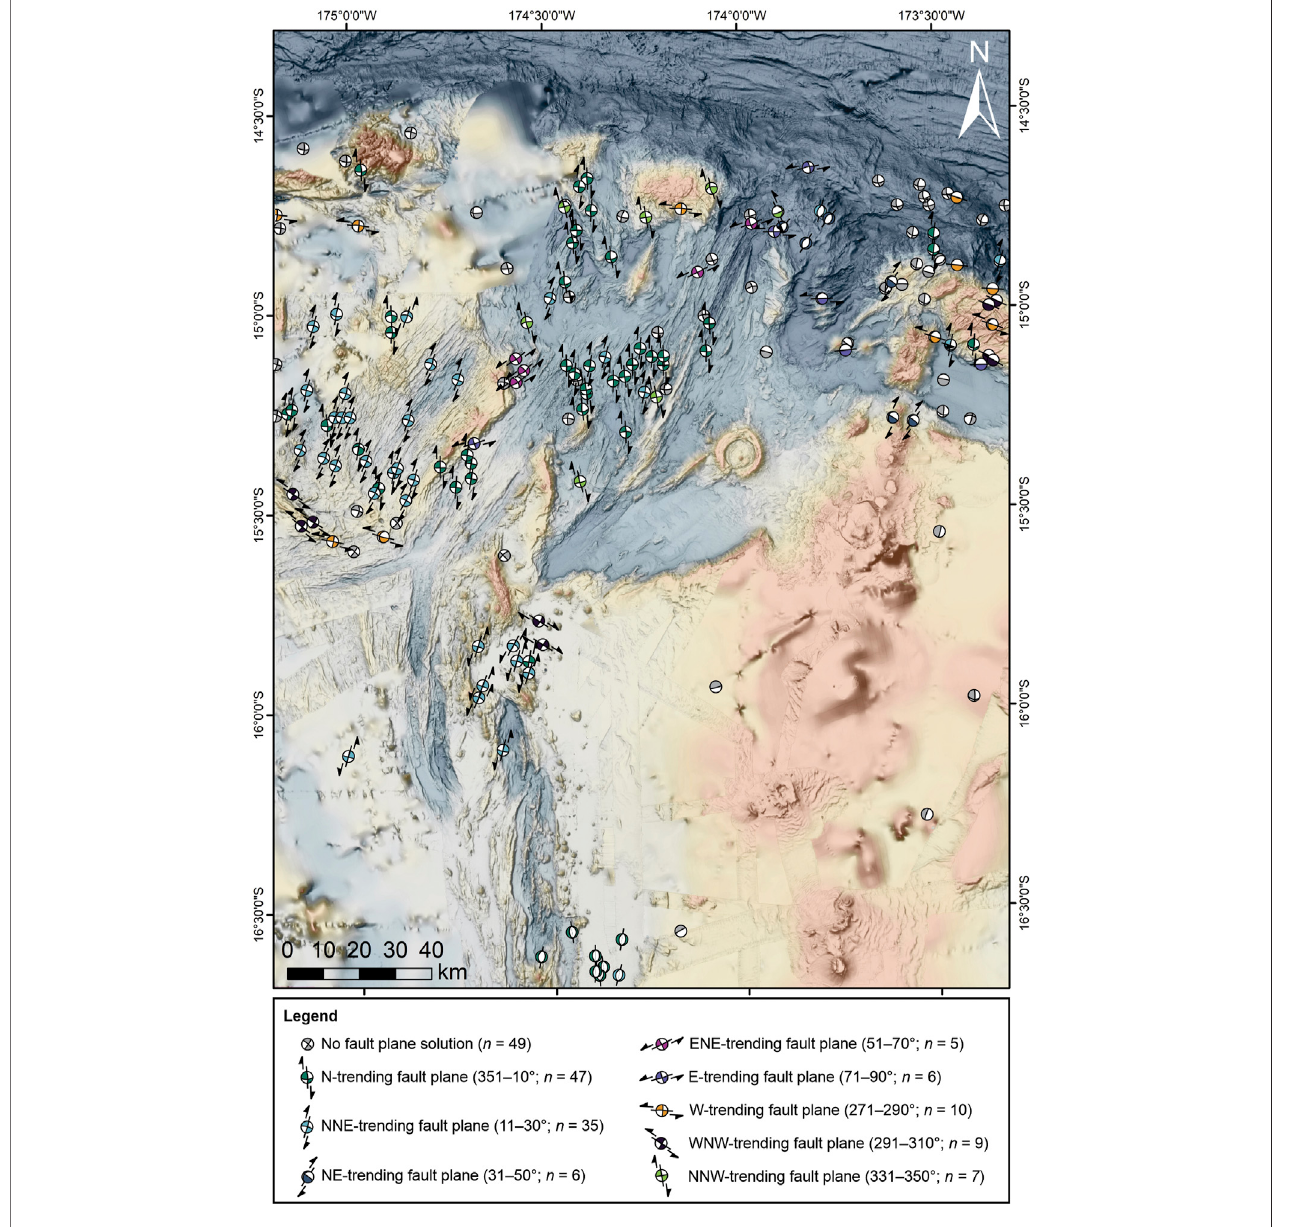
FIGURE 8 | A total of 174 CMTs with shallow depths ( ≤ 25 km) occur within the map area (www.globalcmt.org; Dziewonski et al., 1981; Ekström et al., 2012). Of these, 125 CMT focal plane solutions are interpreted by association with the dominant orientation of the sea fl oor fabric (see Supplementary Figure S4 ). The colors of the CMT “ beachball ” represent the orientation of the focal plane solution outlined in the legend and shown in detail in Figure 7 . Bathymetric compilation as in Figure 3 .